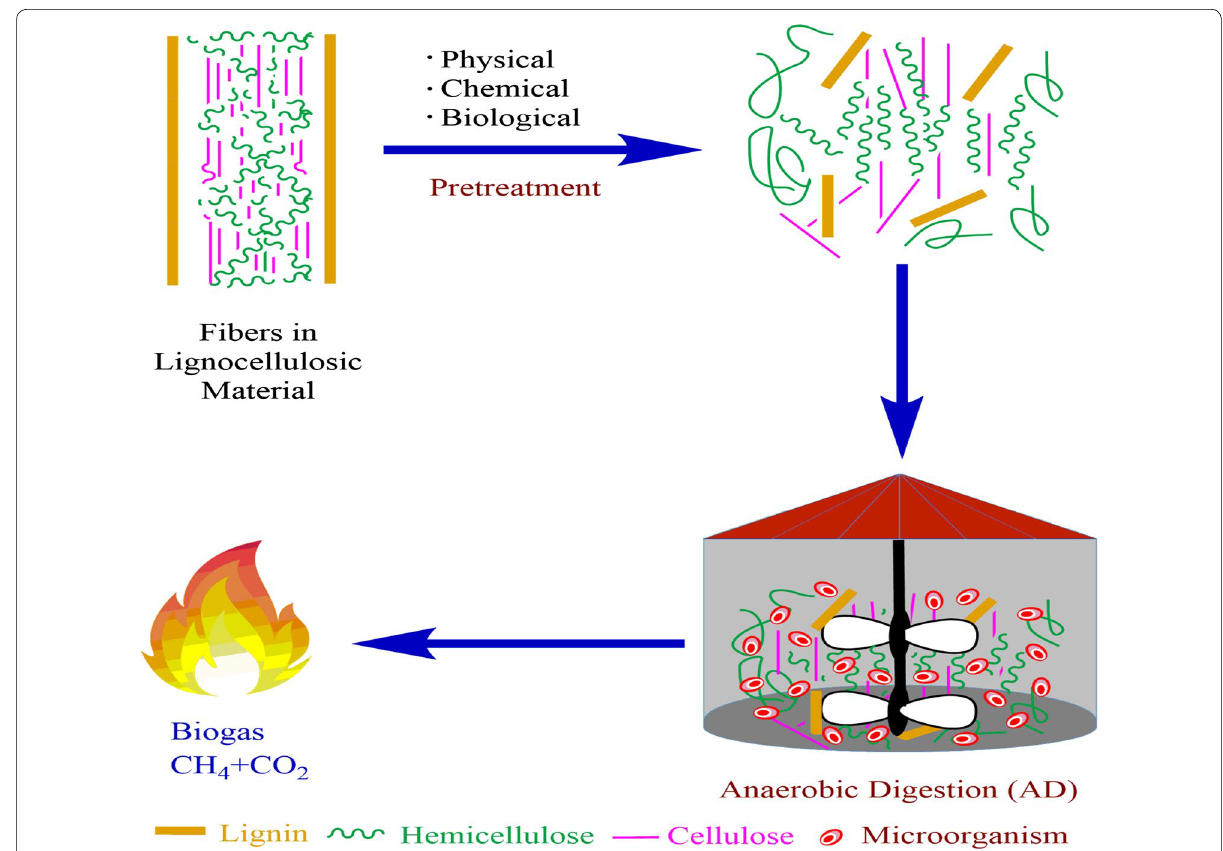
Fig. 2 Schematic diagram of the pretreatment of lignocellulosic material for biogas